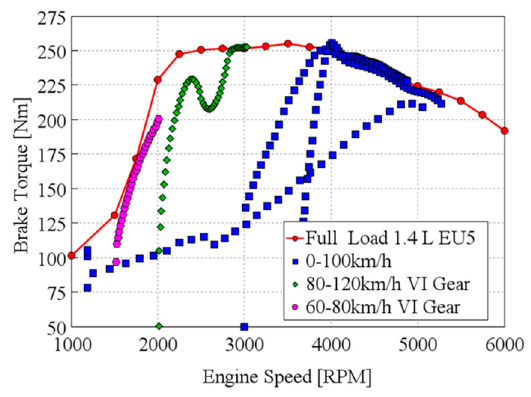
Figure 4. Transient maneuvers reported in the engine map for the reference engine: 0–100 km / h in blue, 80–120 km / h in sixth gear in green and 60–80 km / h in sixth gear in violet.